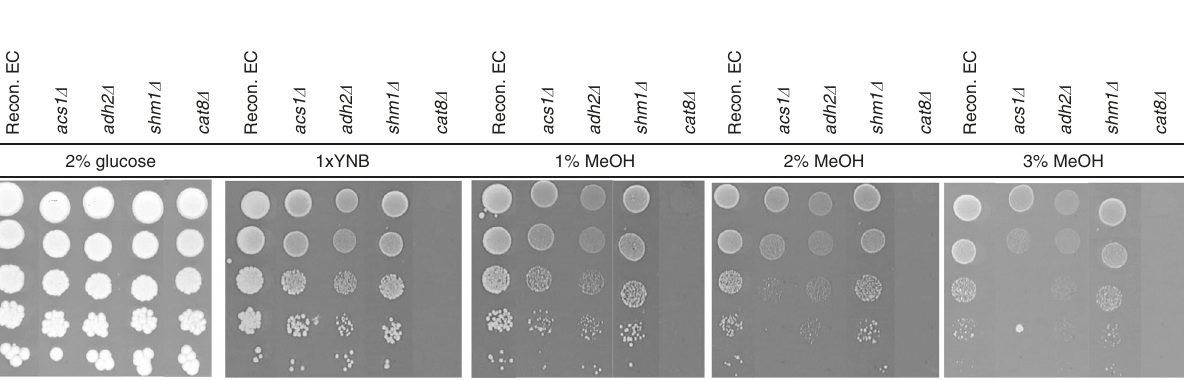
Fig. 5 Growth in methanol of different gene deletions to test their putative involvement in S. cerevisiae ’ s native methanol assimilation. Growth on solid 1×YNB medium with different carbon sources was tested using serial ten-fold dilutions of the reconstructed evolved strain with an empty vector or ACS1, ADH2 , SHM1 or CAT8 deletions. Yeast nitrogen base (YNB), yeast extract (YE), methanol (MeOH). Images were taken after incubating at 30 °C for 6 days. Images are representative of two repeated